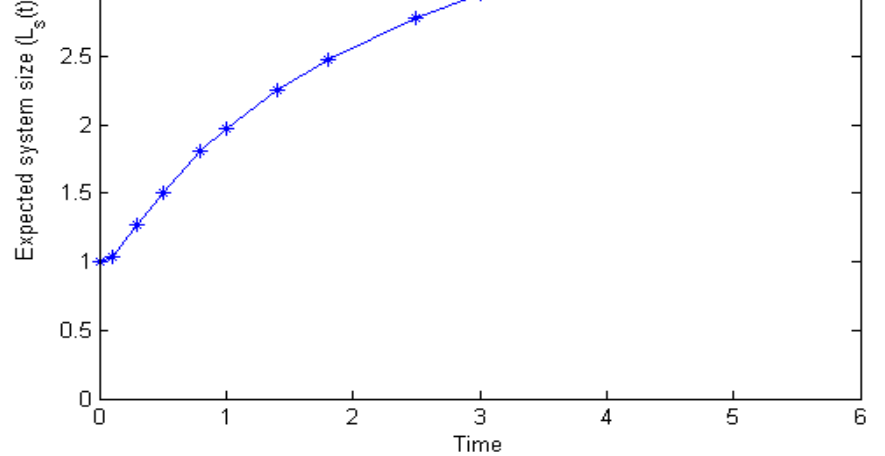
Figure 2. Expected system size vs. time